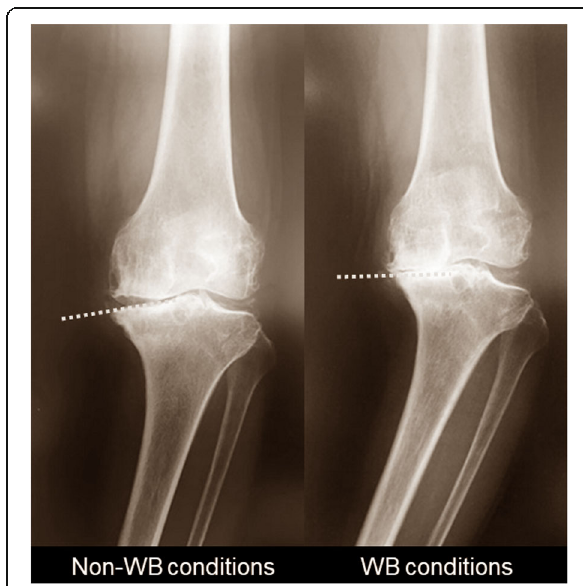
Fig. 1 Knee radiographs in advanced knee OA under non-WB and WB conditions. An articular surface in the MCT under WB conditions was aligned parallel to the ground, compared to that under non-WB